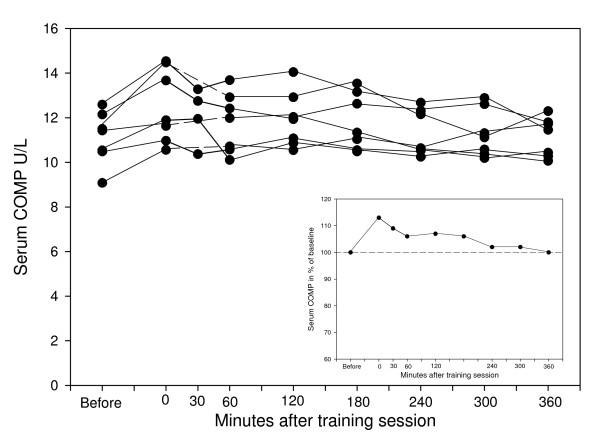
Serum COMP after standardised exercise in seven patients recruited from the exercise group in study 1. Serum COMP concentrations after a one-hour supervised exercise session in 7 patients, study 2. Each line represents an individual patient. The inserted figure shows serum COMP concentration in percent of baseline after a one-hour supervised exercise session.